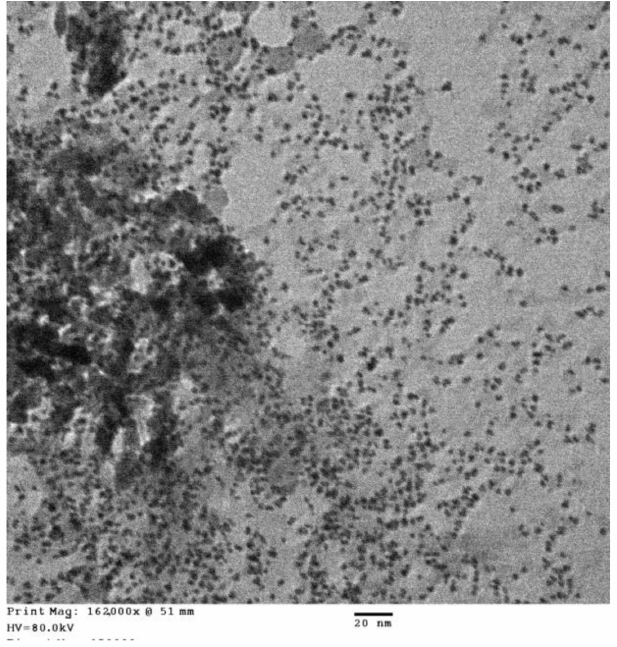
Figure 10. TEM image of biosynthesized palladium